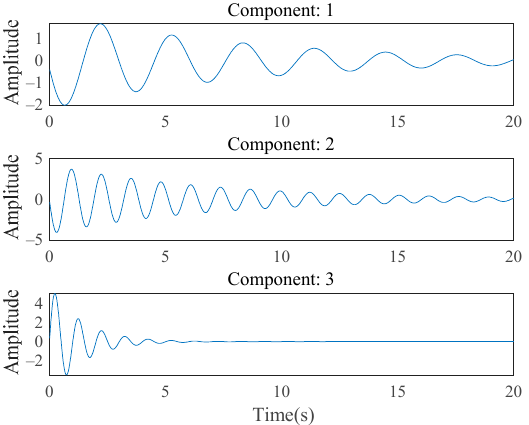
Figure 12. Dominant components of signal B identified by SMPI.